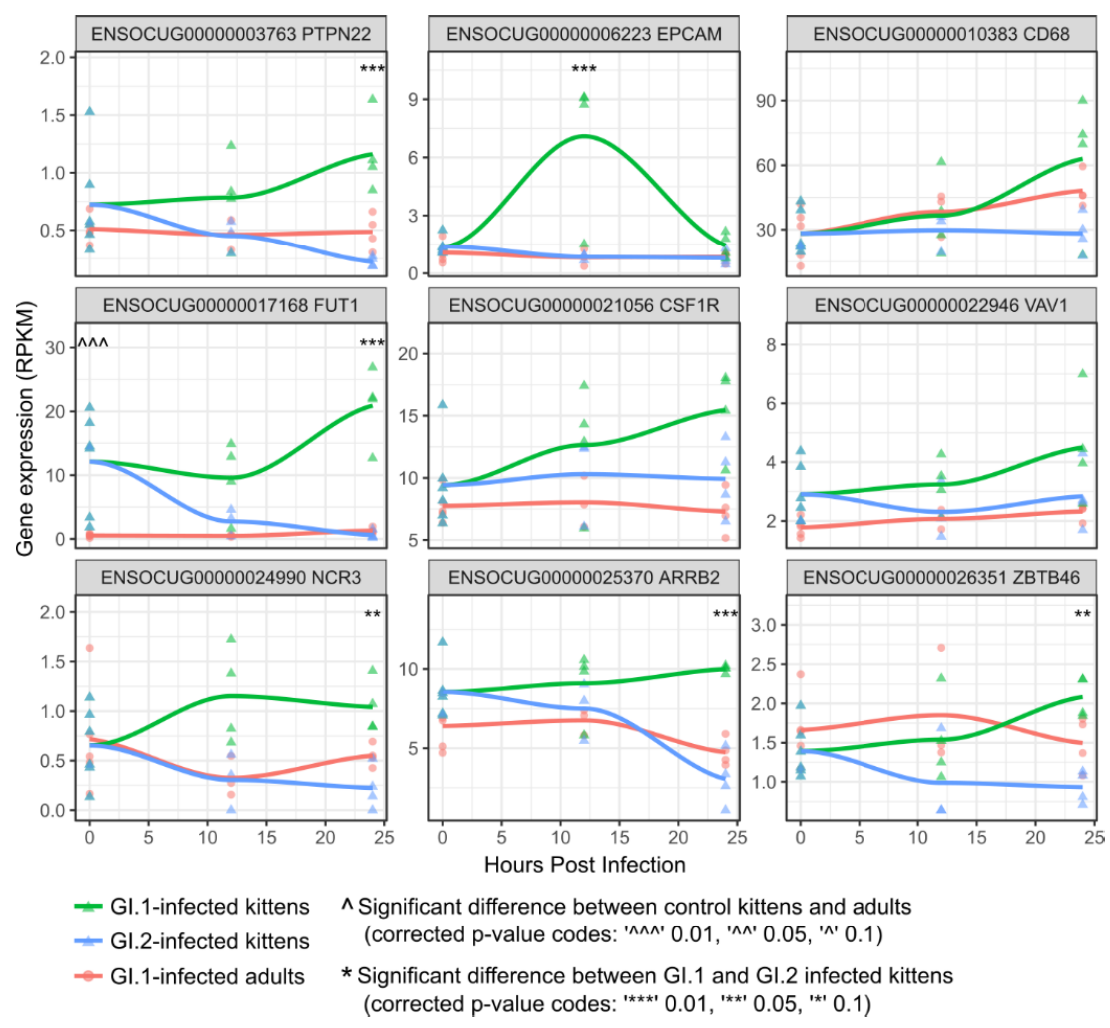
Figure 4. Regulation of key markers for natural killer cell ( PTPN22 , VAV1 , ARRB2 , and NCR3 ), macrophage ( CSF1R , ZBTB46 , and CD68 ), and cholangiocyte development ( EPCAM ) during GI.1 and GI.2 infections. The header in each plot gives the Ensembl gene accession followed by the gene symbol.